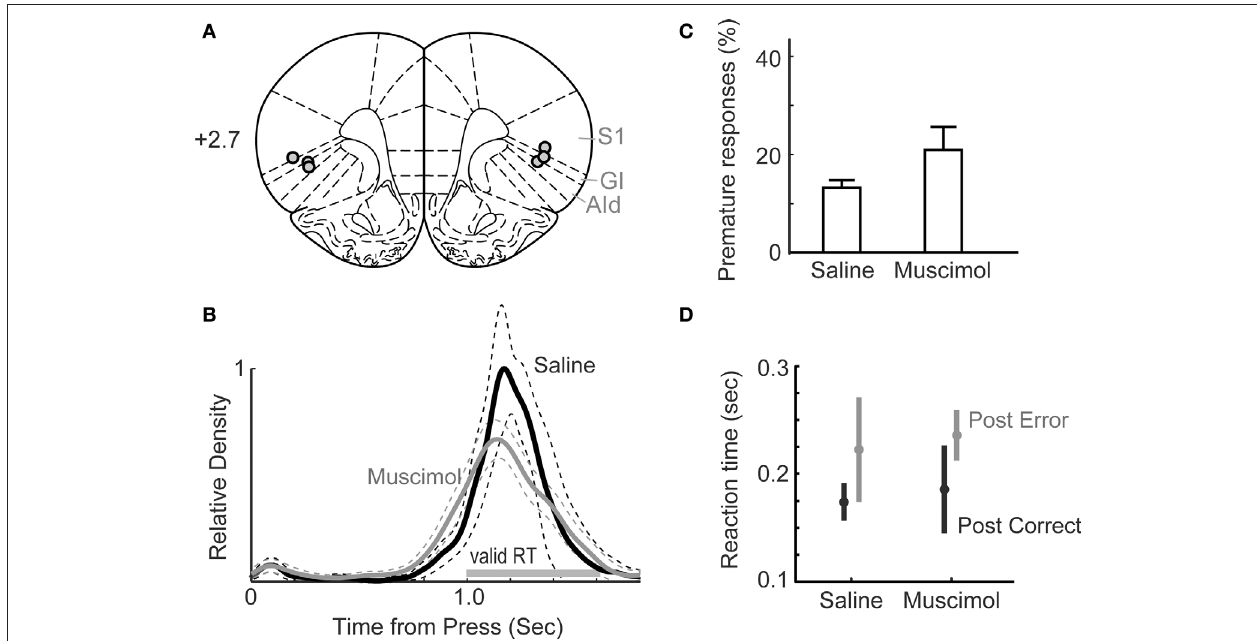
observed with saline in IC, but the difference was not significant ( t -test: P > 0.05). (D) Mean RTs from sessions with saline or muscimol in IC and trials preceded by correct (post-correct) and premature error (post-error) responses were not significantly different ( t -test: P > 0.05). In both types of sessions, RTs were longer on trials preceded by errors compared to trials preceded by correct responses ( t -test: P <